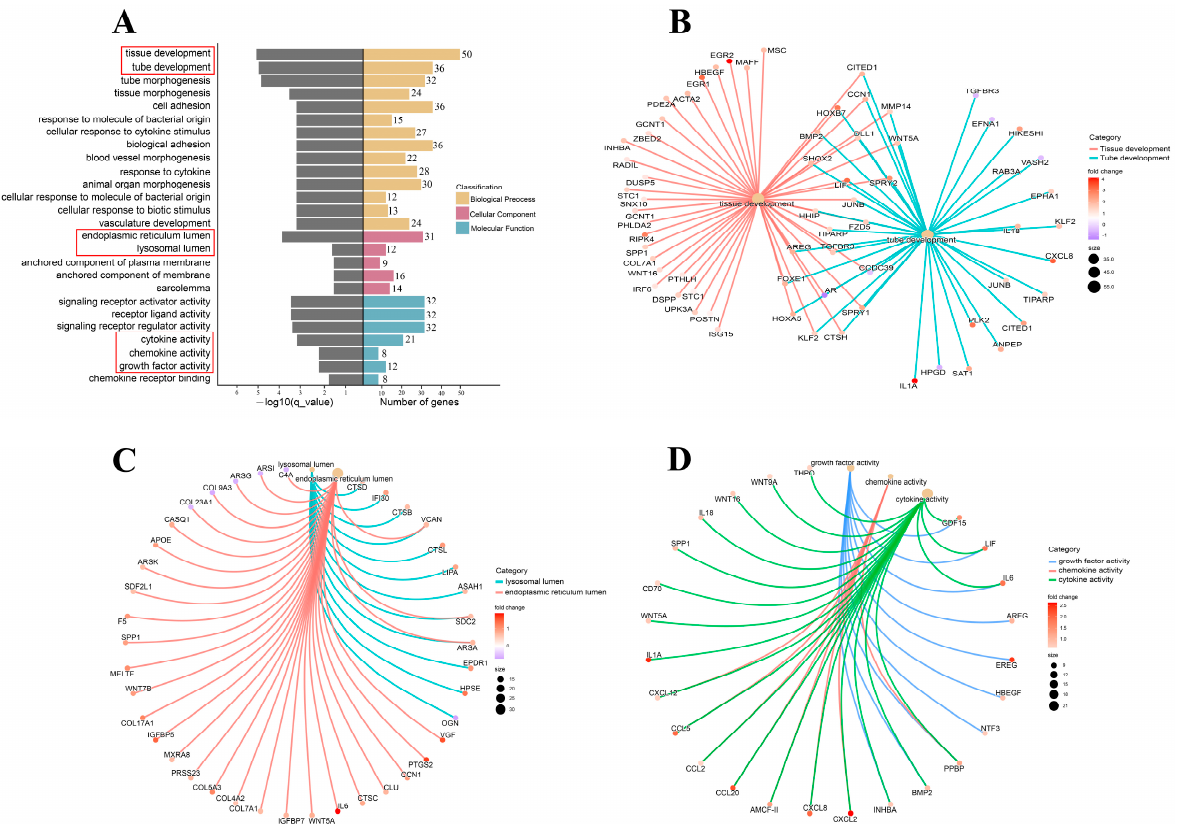
Figure 4. GO enrichment analysis of DEGs. ( A ). GO functional items enriched by DEGs. ( B ). DEGs enriched in tissue and tube development. The color changes of the dots correspond to fold changes of DEGs. The different color connections represent DEGs participating in different molecular processes. ( C ). DEGs enriched in endoplasmic reticulum and lysosomal lumen. ( D ). DEGs enriched in cytokine, chemokine, and growth-factor activity.